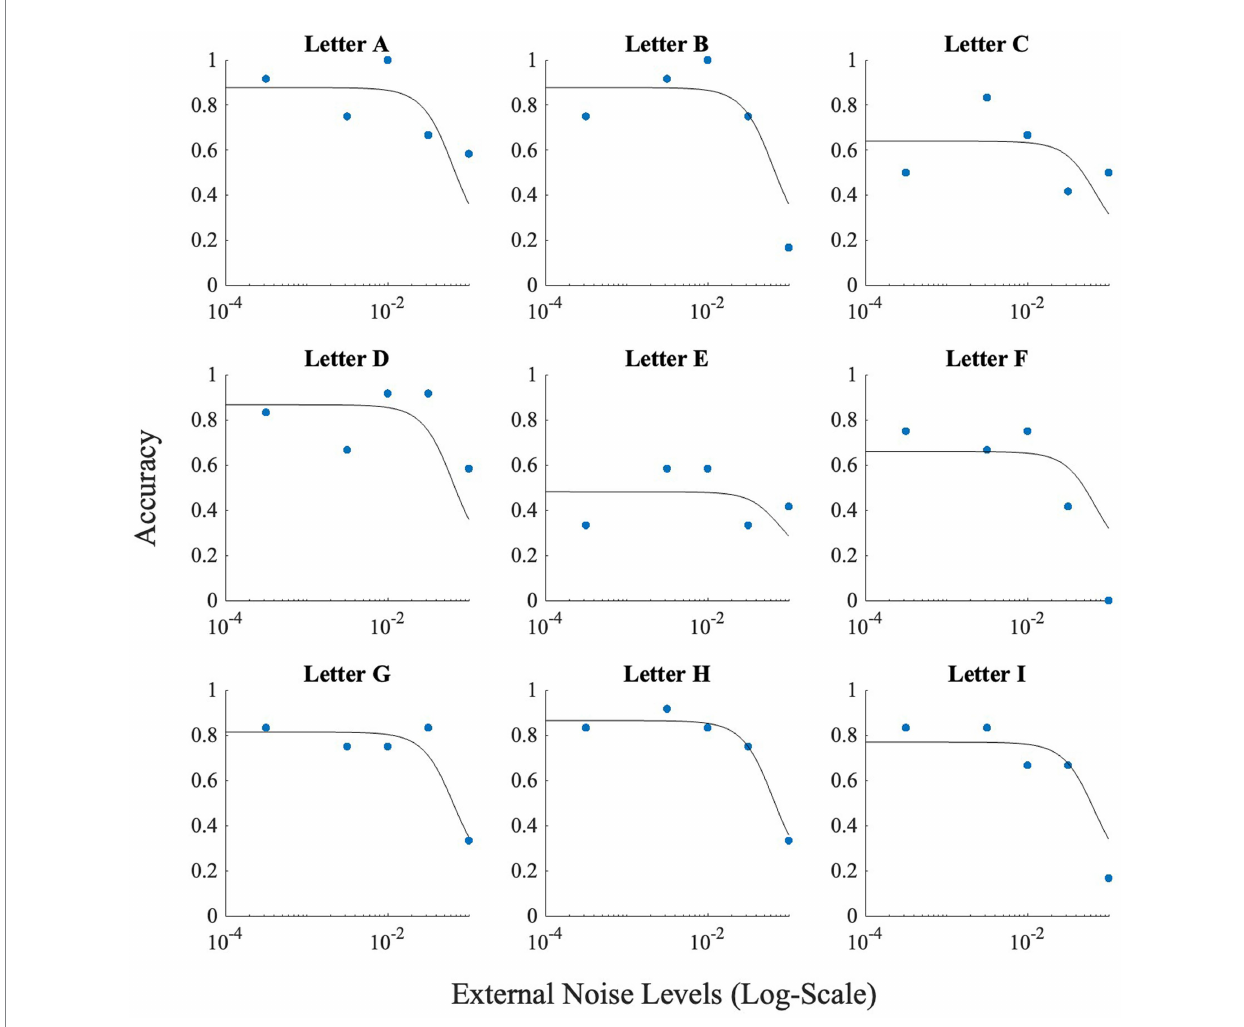
FIGURE 14 An example fit of Model 3 to one participant. The fit produced no SR for this participant. Horizontal axis ( x -axis) represents noise levels in log-scale, and the vertical axis ( y -axis) shows accuracy. Accuracy at zero external noise was plotted at a level of 3 × 10 − 4 of external noise. Lines show the fit of the model (Model 3) to this